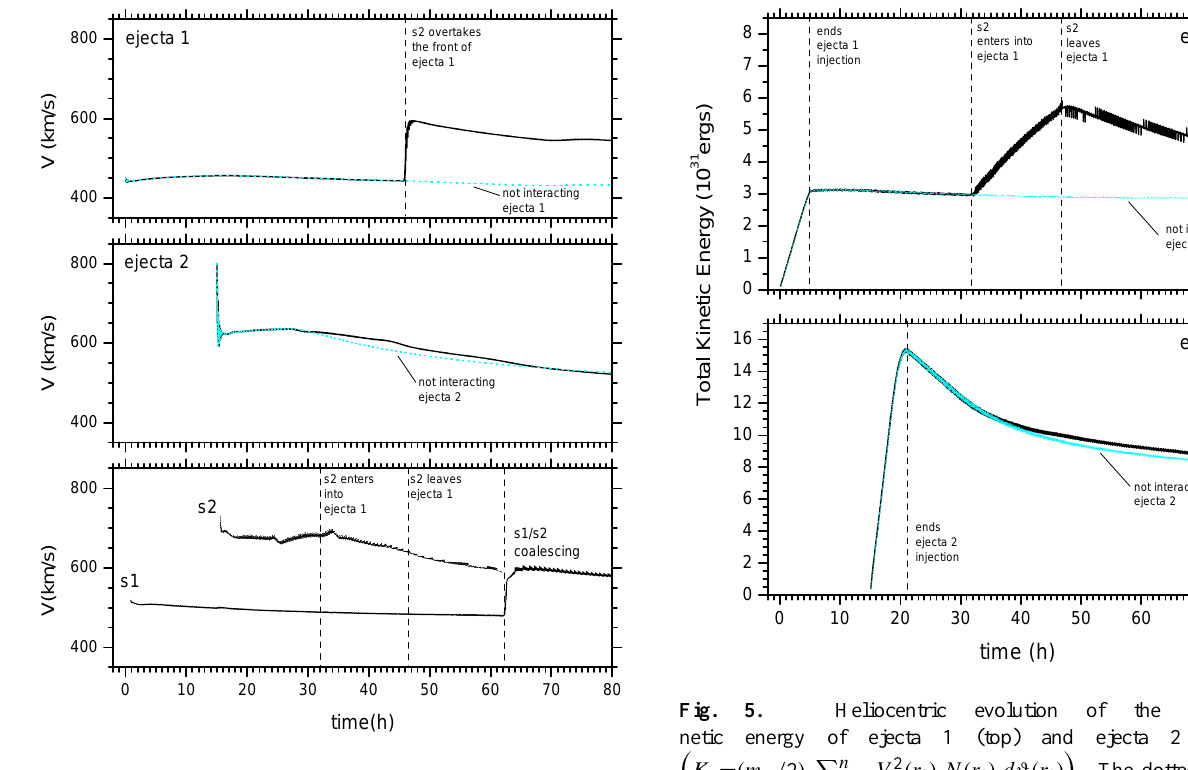
Fig. 3. Evolution of the velocities of the front of ejecta 1 (top), ejecta 2 (middle) and their associated shock waves (bottom). Ejecta 2 is injected 15h after ejecta 1 initiation. The dotted curve in the top and middle plots show the evolution when there was no interaction with any other ejecta.